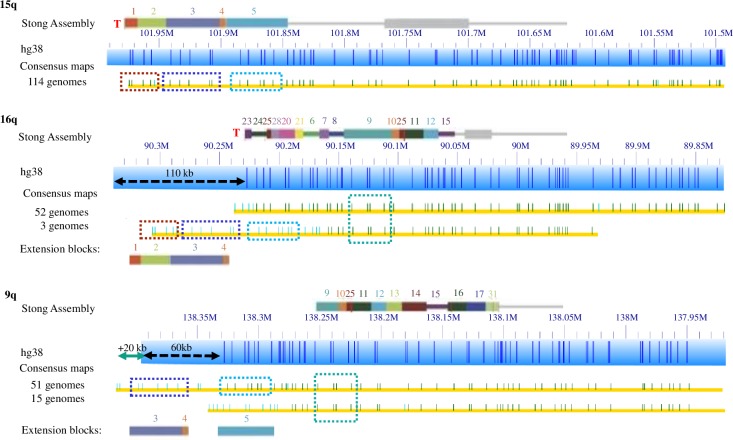
Distribution of paralogy block 5 in 15q, 16q and 9q.The solid color rectangle bars show the paralogy blocks defined in the subtelomeric assemblies of Stong et al. (2014). The narrow grey line segments to the right of the colored blocks show the single-copy DNA region. Blue rectangles with dark blue lines show the HG38 reference with Nt.BsPQ1 nick sites. Paralogy block five is shown as a dashed blue rectangle on top of yellow rows representing consensus maps for particular genomes. Additional paralogy blocks are also shown as dashed colored rectangles. A teal arrow indicates the size of additional extended regions not covered by the reference. A black arrow represents unknown sequence currently in the HG38 reference as ‘N’, an estimate of gap size to the end of the chromosome. If the black arrow is dashed it signifies a region of unknown telomere-adjacent gap sequence that should be deleted.